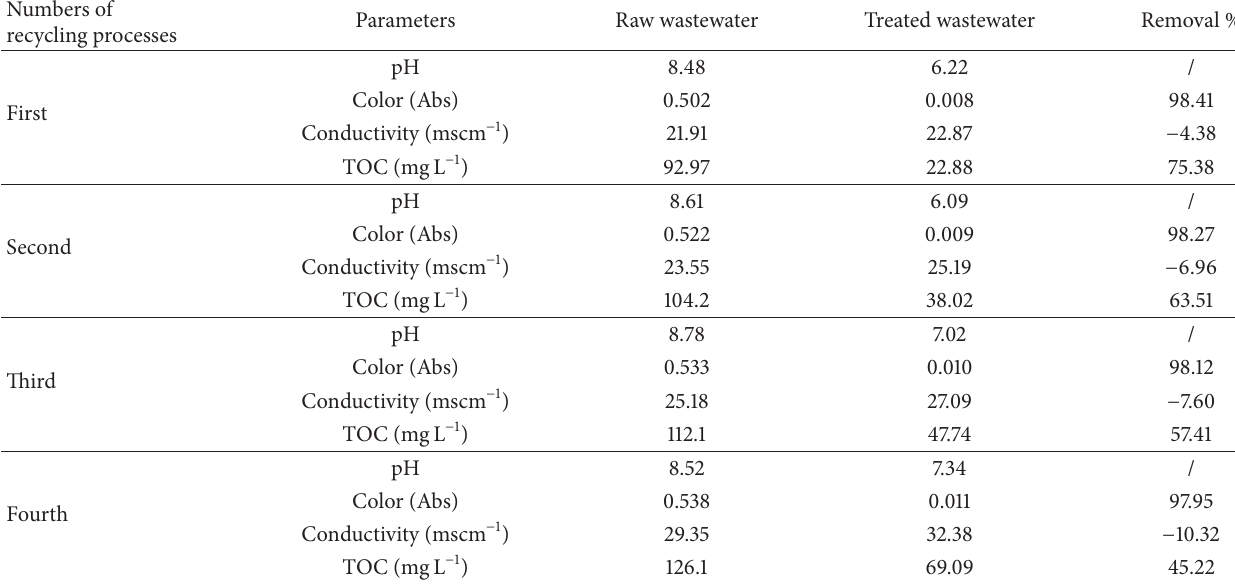
Table 2: Characteristics of raw and decolorized dyeing